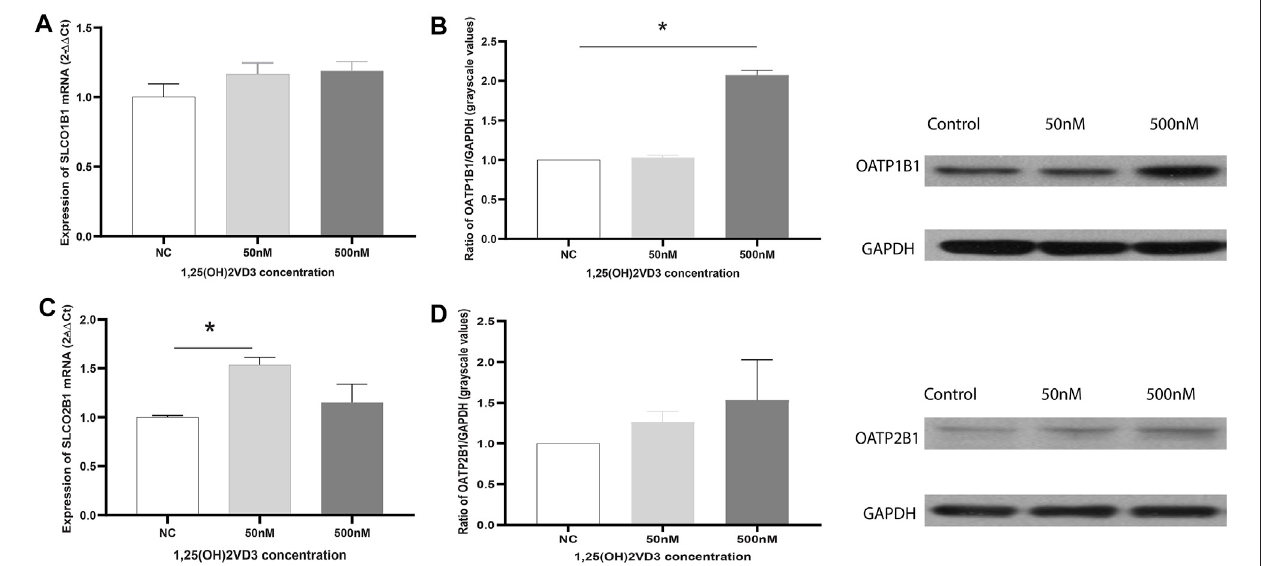
FIGURE 6 | Effects of 1,25(OH)2VD3 on OATP1B1 and OATP2B1 expression in Huh7 cells. (A) SLCO1B1 mRNA expression. (B) OATP1B1 protein expression. (C) SLCO2B1 mRNA expression. (D) OATP12B1 protein expression. 2 − △△ Ct and grayscale ratio values of OATPs and GAPDH were used to compare the genes and protein expression between the groups, respectively, and GAPDH was used as the reference gene. NC: Blank control (ethanol), 50 and 500 nM: different groups using 50 and 500 nM 1.25(OH) 2 VD 3 . * p < 0.05: statistically signi fi cant difference, using ANOVA followed by Tukey ’ s post-hoc test.